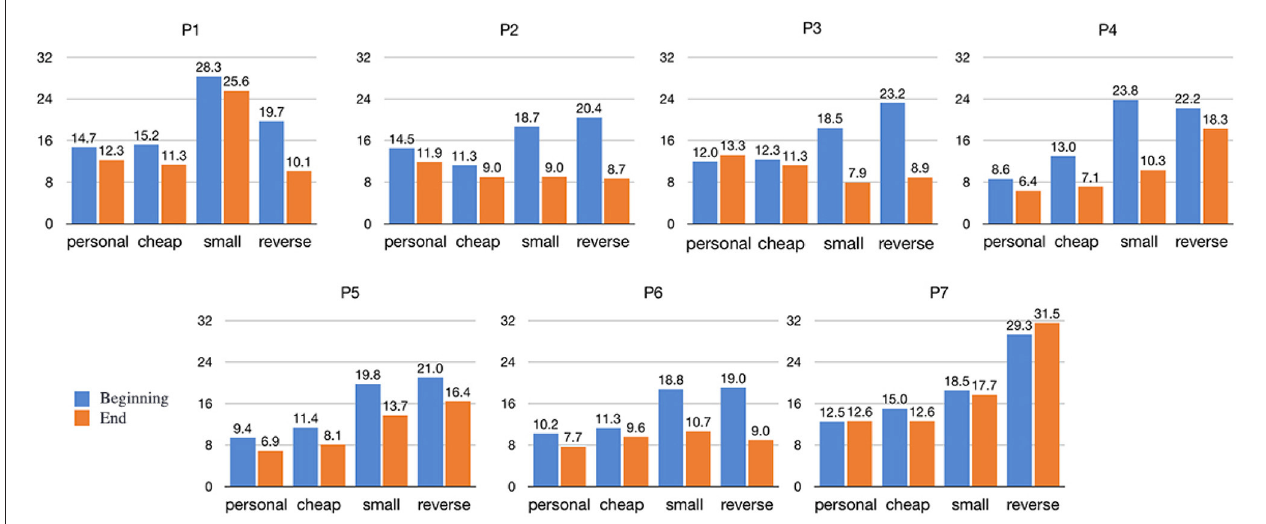
FIGURE 7 | Means of absolute pitch errors for each performer at the beginning and at the end of the